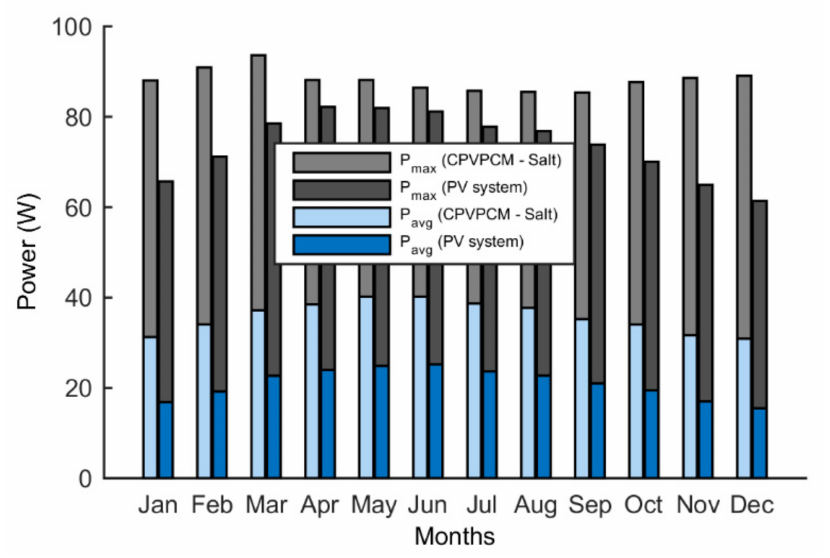
Figure 16. Comparison of maximum and average power of CPVPCM system with salt and PV system.